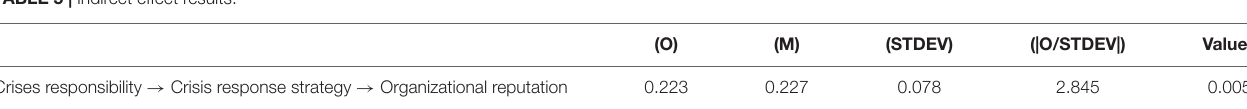
TABLE 5 | Indirect effect